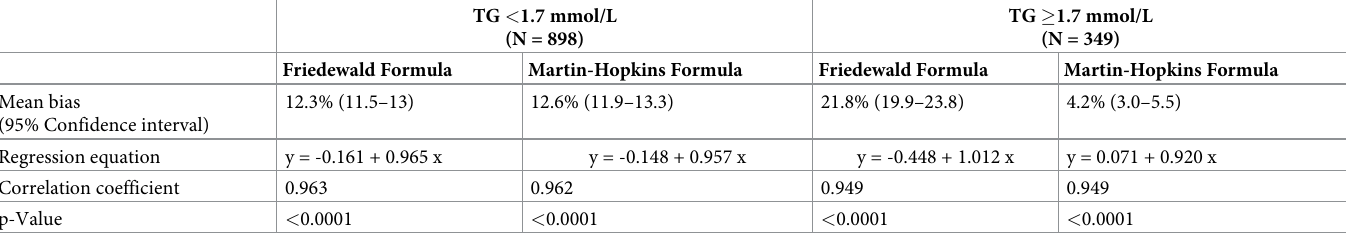
Table 3. The mean bias, regression equation, correlation coefficient and p-value of measured and calculated low-density lipoprotein at different triglycerides (TG)